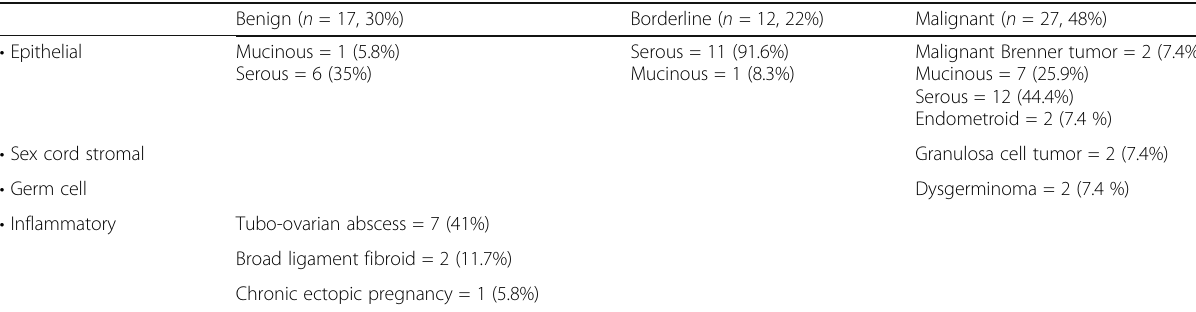
Table 3 The different final pathological types of the examined lesions Benign ( n = 17, 30%) Borderline ( n = 12,